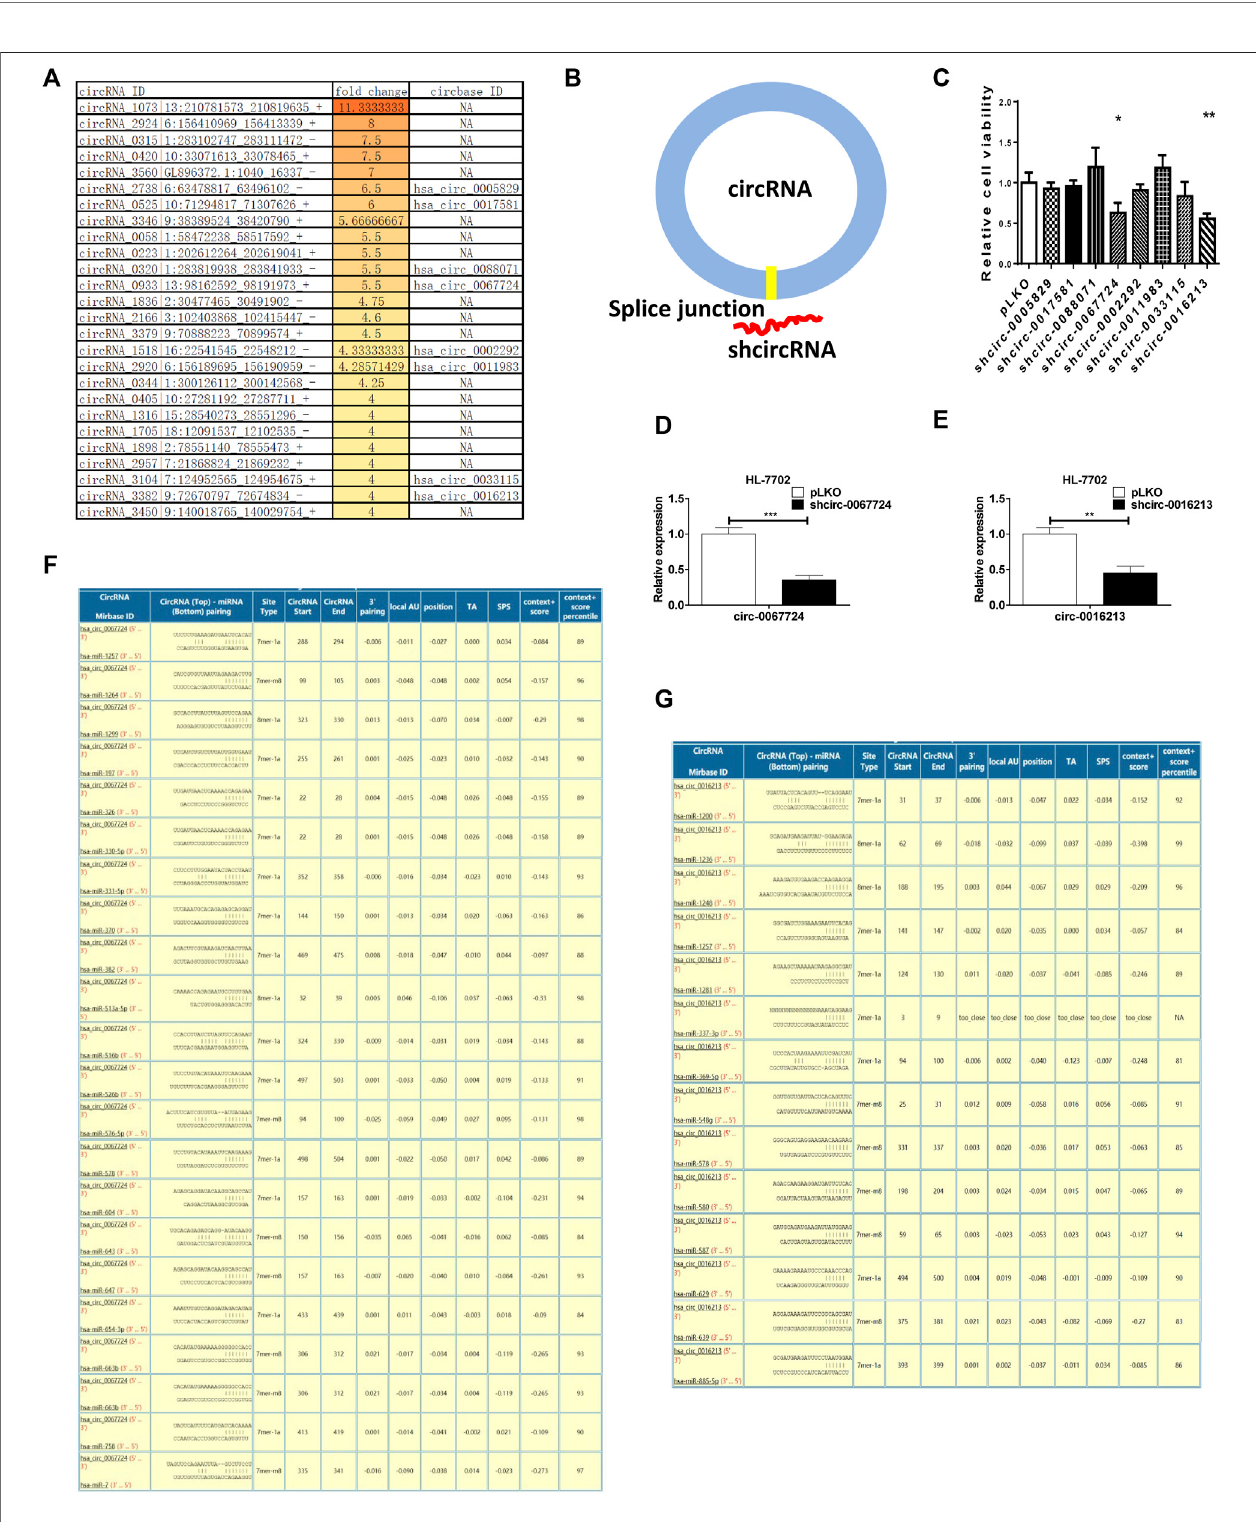
FIGURE 4 | Loss of circ-0067724 or circ-0016213 could suppress liver regeneration. (A) Top 26 increased circRNAs in postoperative left liver tissue and eight homologous genes of humans and pigs. (B) Schematic illustration showing the position of the targeting shRNA to knock down the circRNAs. (C) MTT assays to detect the function of shcircRNA. (D,E) qRT-PCR was used to con fi rm the knock down ef fi cacy in HL-7702. (F,G) Potential downstream miRNAs relative to circ-0067724 or circ-0016213. The quanti fi cation is presented as mean ± SD, *p < 0.05, **p < 0.01, and ***p < 0.001.